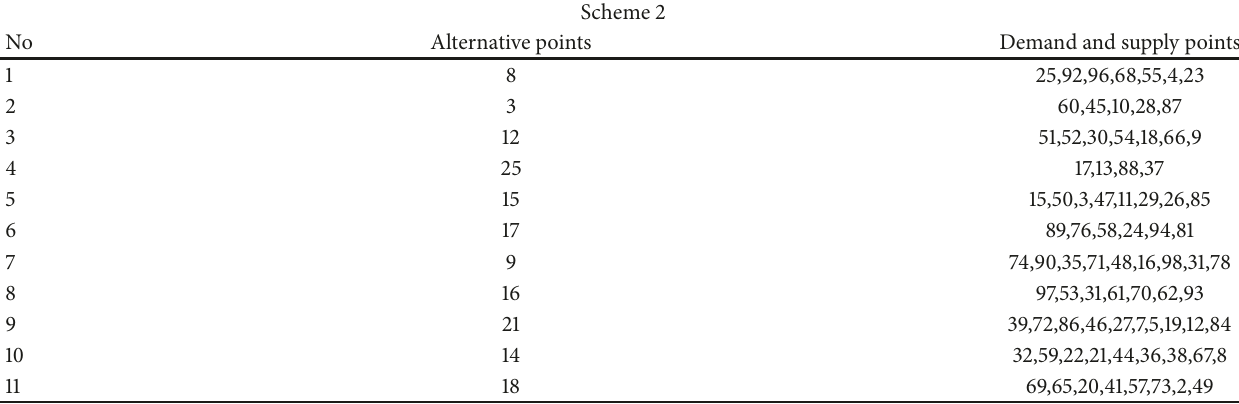
Table 10: The relationship between location and demand distribution of scheme 2. Scheme 2